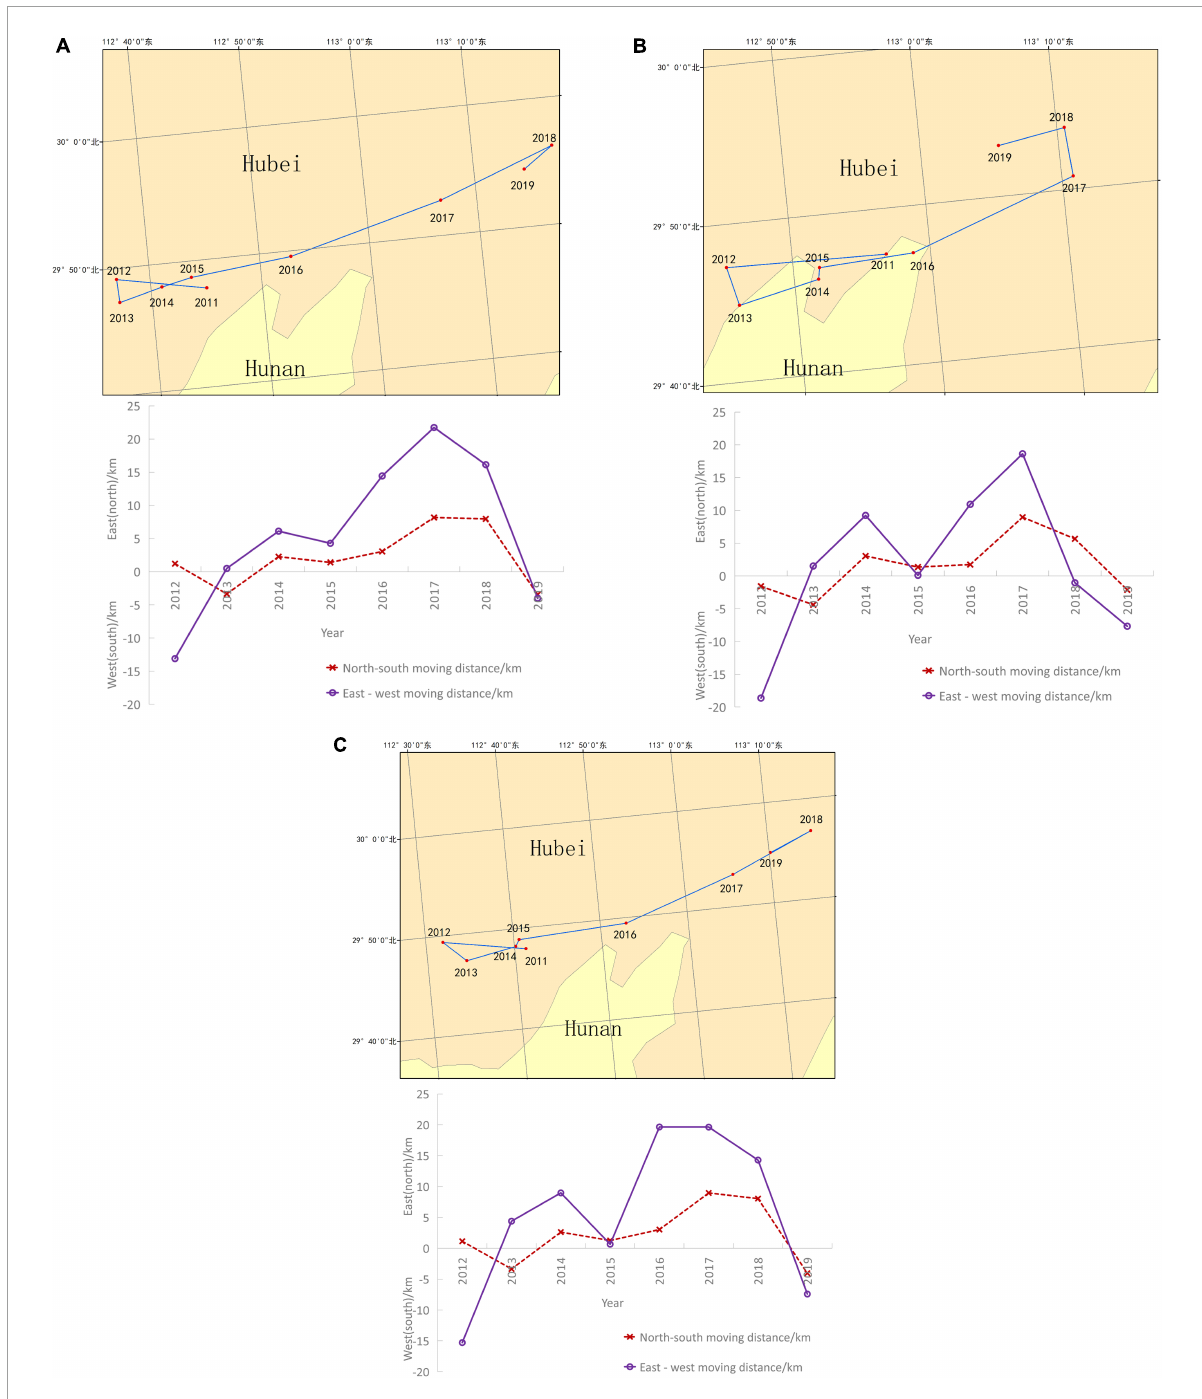
FIGURE5 Transfer of the center of gravity of input–output efficiency of subsystems. (A) Water. (B) Energy. (C) Food.